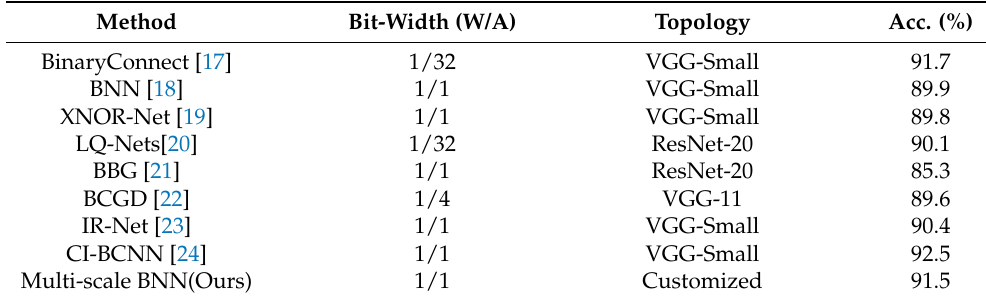
Table 2. Image classification performance of binary neural networks on CIFAR-10 dataset [16].